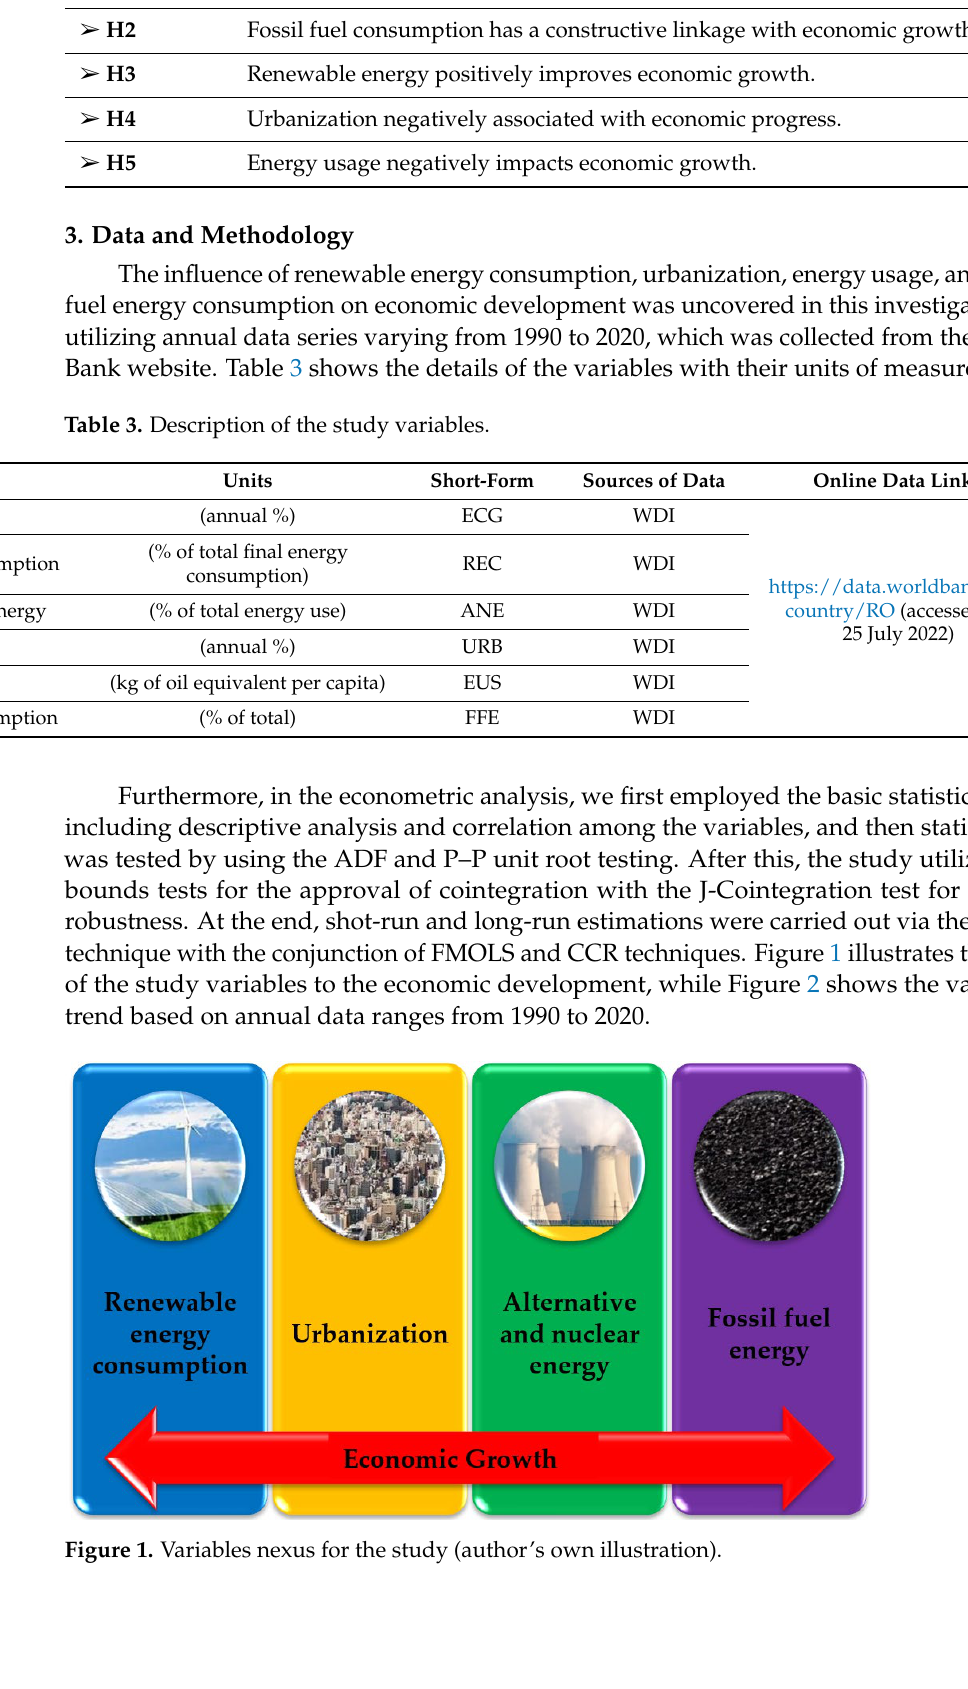
Table 2. Hypotheses of the Study.